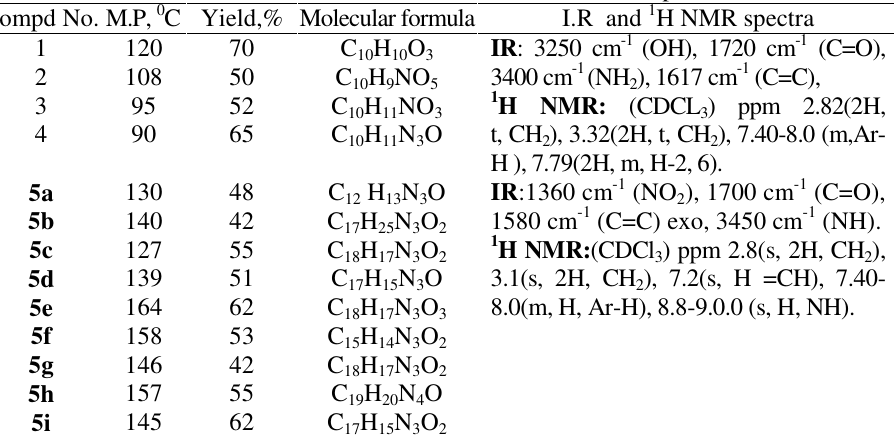
Table 1. IR and 1 H NMR characteristics of the